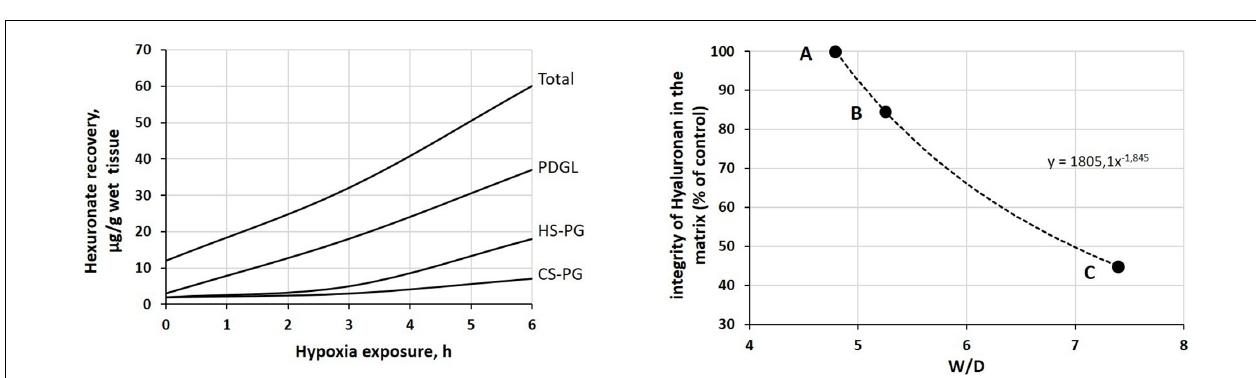
FIGURE 4 | Relationship between interstitial hydraulic pressure (Pint) and wet-to-dry weight (W/D) ratio at end-expiration. Point A corresponds to physiological condition; point B to the “safety factor” (see text for explanation); point C corresponds to the absence of the “safety factor” reflecting the remarkable loss of integrity of the interstitial matrix (Miserocchi et al., 1990, 1993).